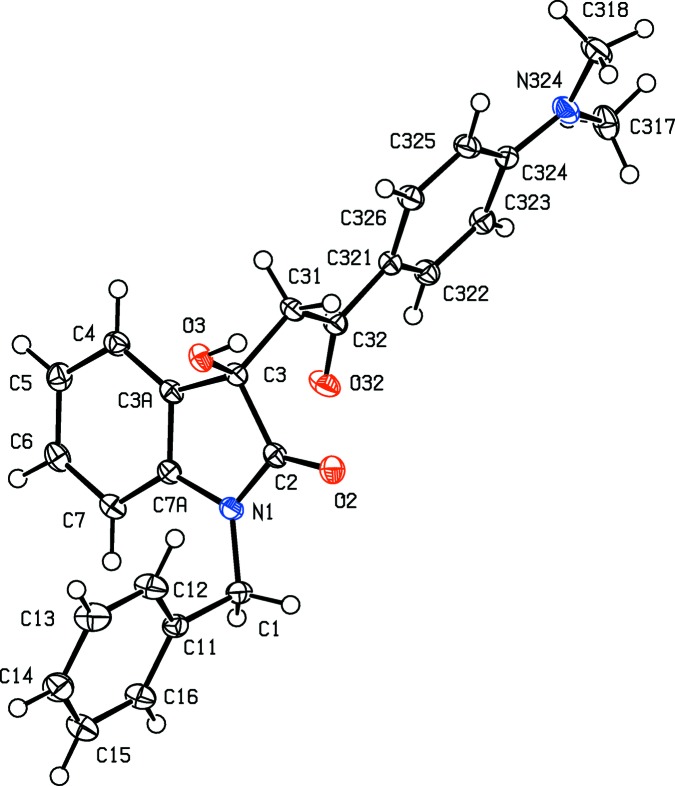
The mol­ecular structure of the R enanti­omer of com­pound (Id), showing the atom-labelling scheme. Displacement ellipsoids are drawn at the 30% probability level.